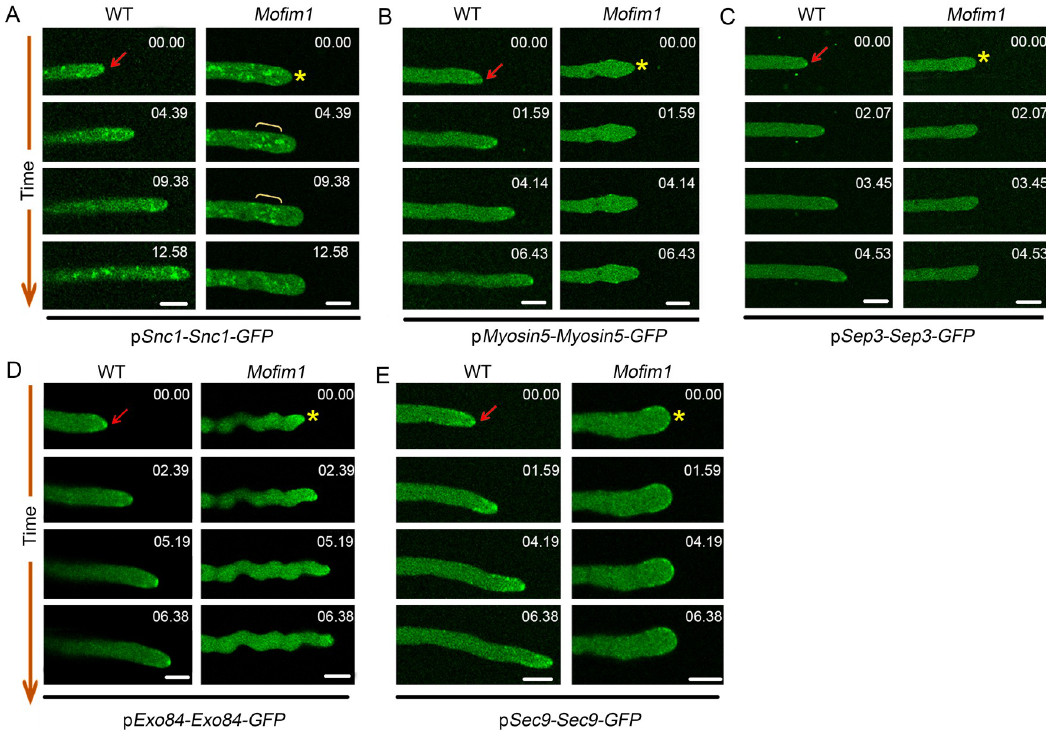
Fig 8. Compromised septin-dependent exocyst in Mofim1 . The indicated genes encoding the v-SNARE protein Snc1 (A) , actin motor protein Myosin5 (B) , actin scaffold protein Sep3 (C) , exocyst component Exo84 (D) , and t-SNARE protein Sec9 (E) were fused with GFP and driven by their native promoters. The constructs were transformed into WT and Mofim1 . The red arrowheads indicate the apical accumulation of the indicated proteins in WT hyphae and the yellow asterisks indicate those in Mofim1 . These images are related to S9–S12 Movies. The numbers at the top right corner indicate the timestamps (min:s). Bars = 5 μ m.